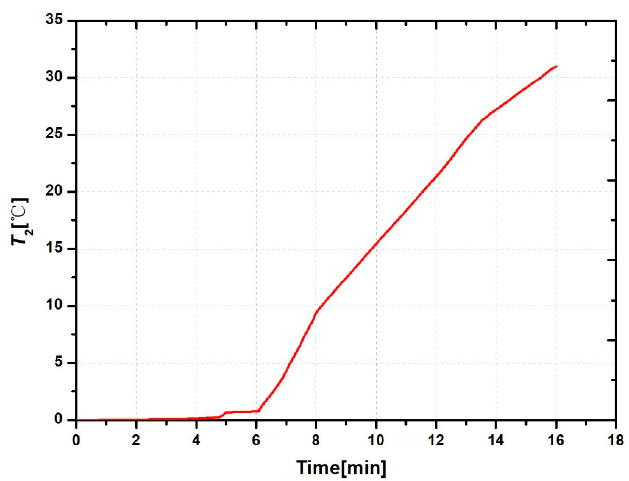
Figure 12. Integrating result of the compressor discharge temperature.